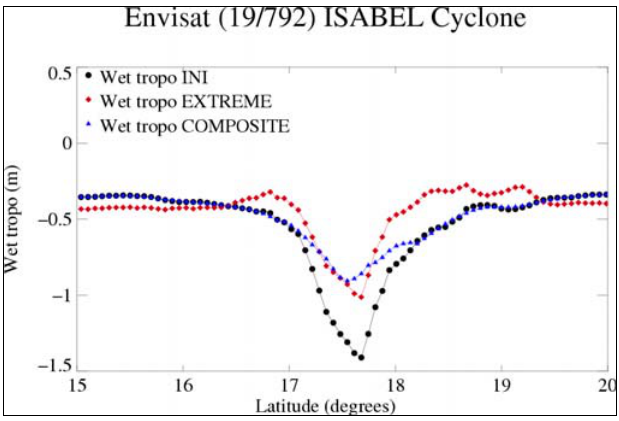
Figure 6. Wet troposphere correction computed for Envisat for TC Isabel (cycle 19-track